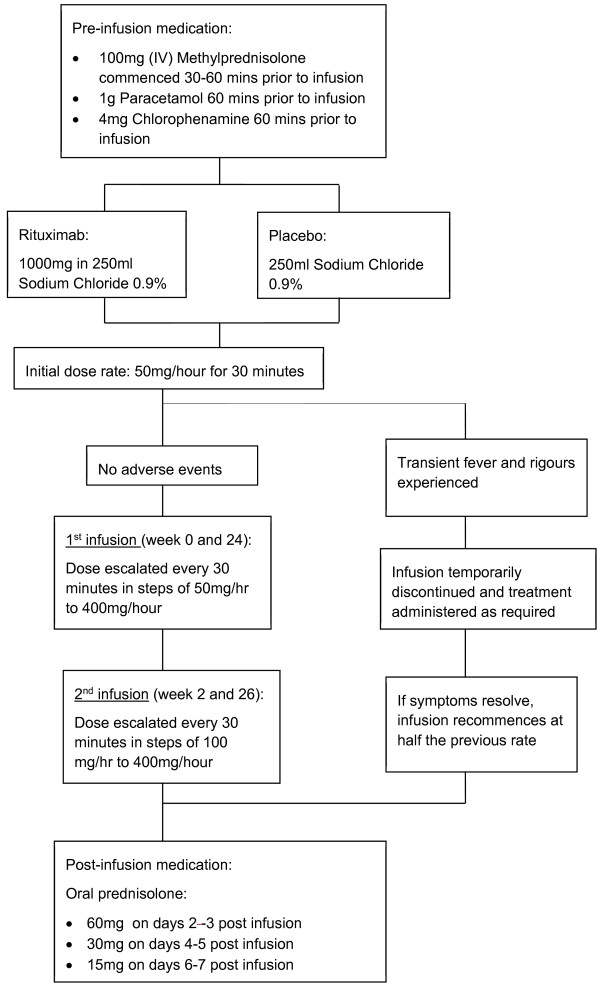
Treatment schedule.